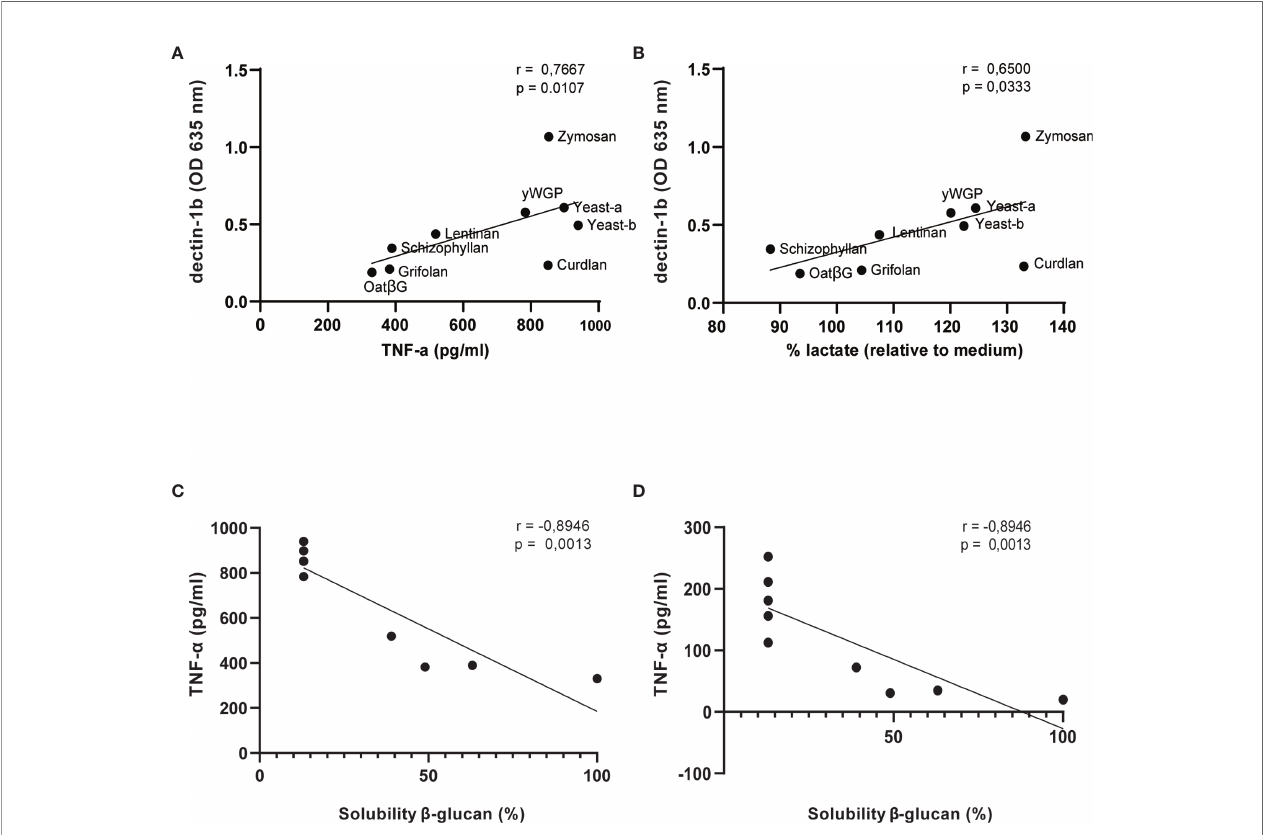
FIGURE 7 | Dectin-1b activation and solubility of b -glucans correlate with macrophage functions following training or induced resilience. Scatterplots displaying SEAP release upon exposure of 5 m g/ml b -glucans to HEK- Blue ™ - Dectin-1b cells and TNF- a (A) or lactate (B) release following training of macrophages. Correlation coef fi cients of Dectin-1b activation with macrophage secretion of TNF- a and lactate upon exposure of 5, 10, 100 and 1000 m g/ml b -glucans are displayed in Supplementary Table 1 . Correlations between b -glucan solubility and TNF- a release following training (C) or resilience (D) testing in macrophages. Solubility of b -glucans was measured previously by de Graaff and colleagues (31): oat b G (100%), curdlan (<13%), grifolan (49%), schizophyllan (63%), lentinan (39%), yWGP (<13%), zymosan (<13%), yeast-a (<13%) and yeast-b